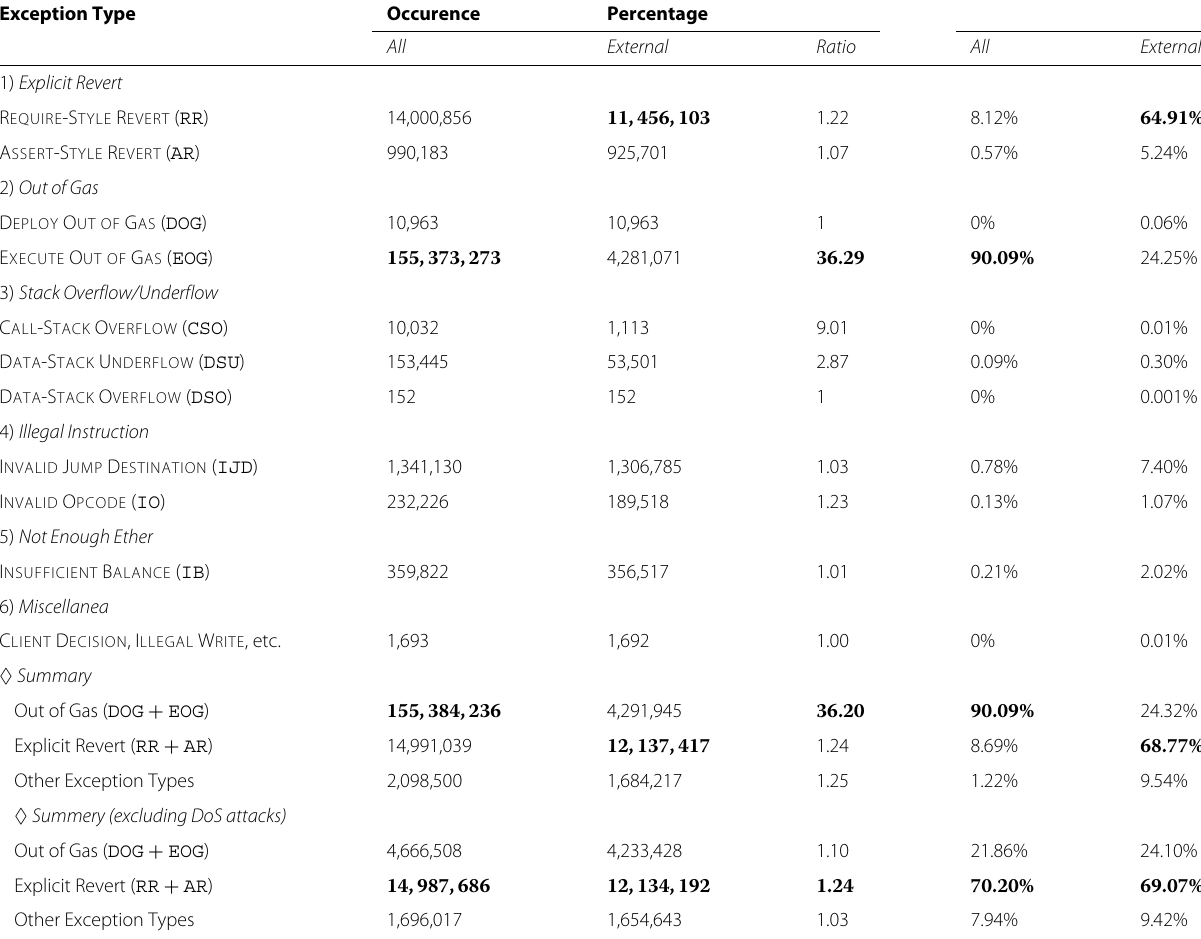
Table 2 Comparing out of gas exception with other exception types in